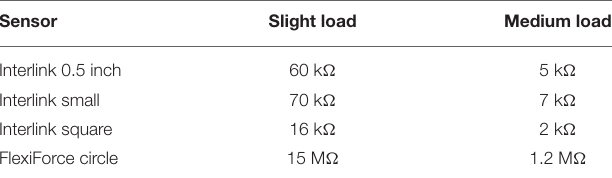
TABLE 1 | Resistance response from rudimentary pressure application.